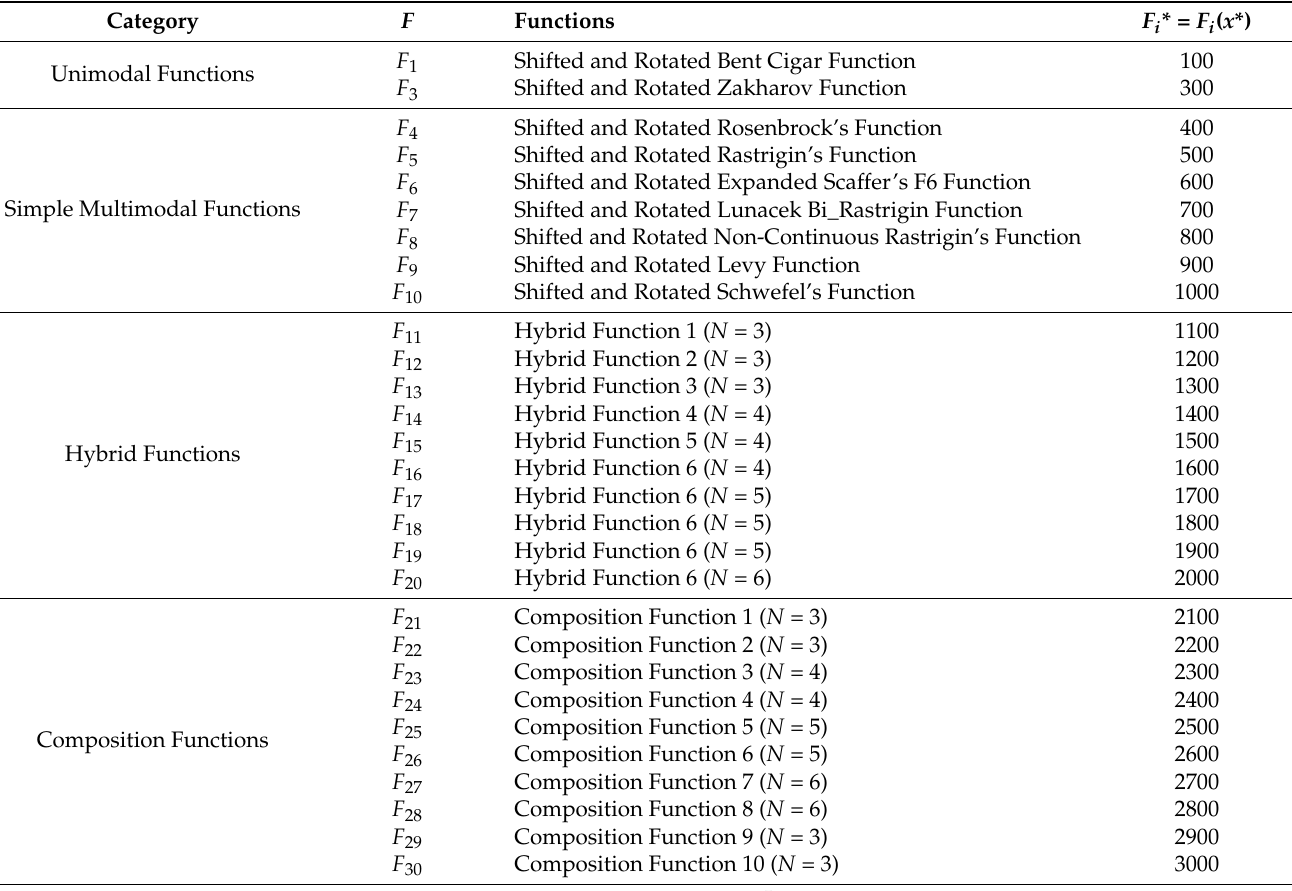
Table 1. The summarized characteristics of the CEC 2017 benchmark